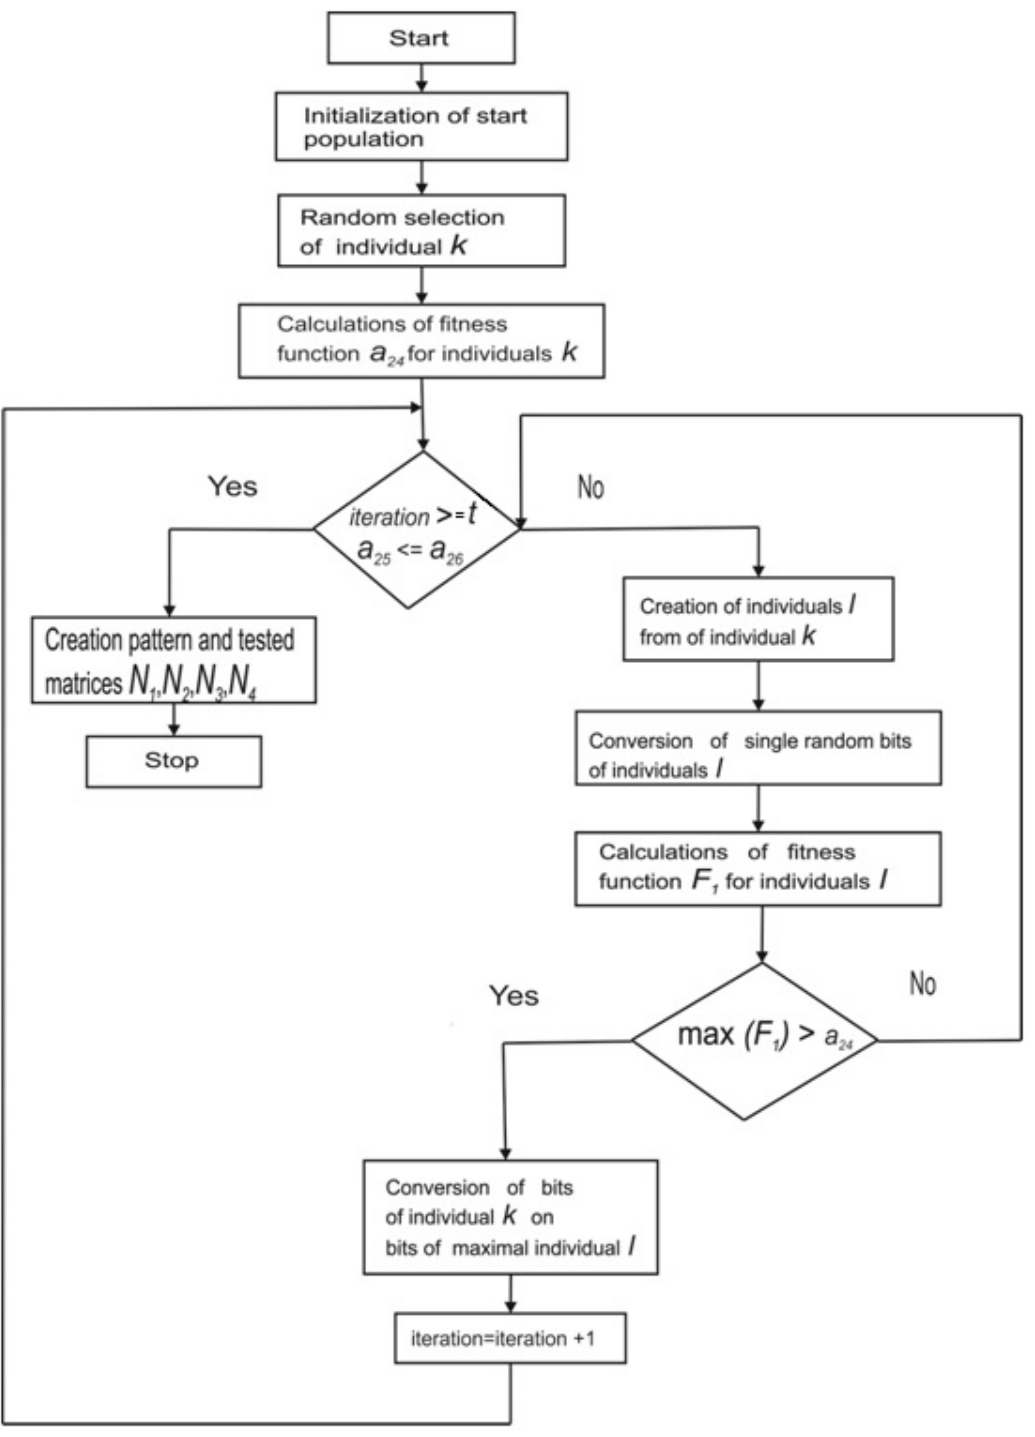
Figure 3. Block diagram of the genetic algorithm of the highest growth operation principle. Selection of the k th individual from all the individuals in each population and re- placement of the individual bits of some amount l of new individuals occurs in a random manner